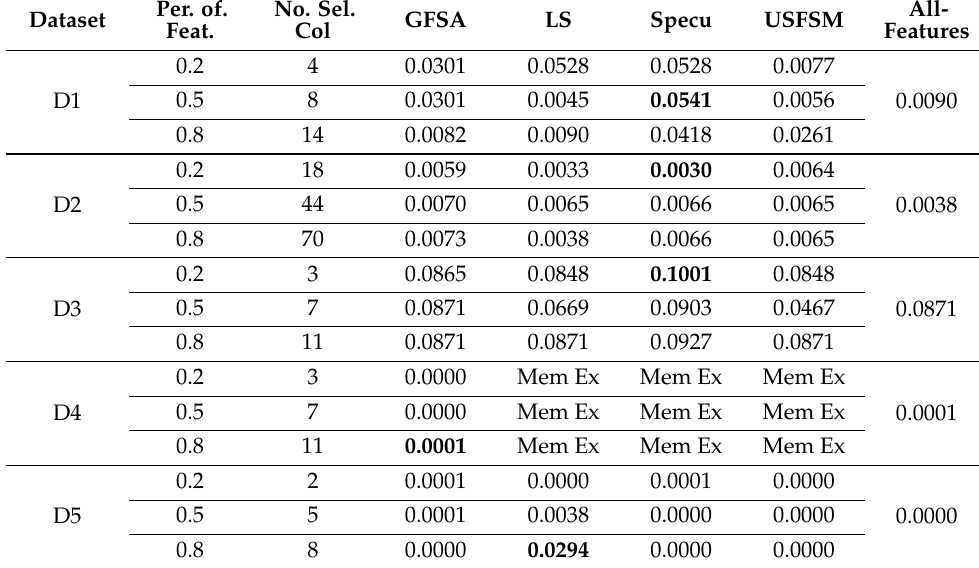
Table 3. NMI accuracy for insurance datasets.